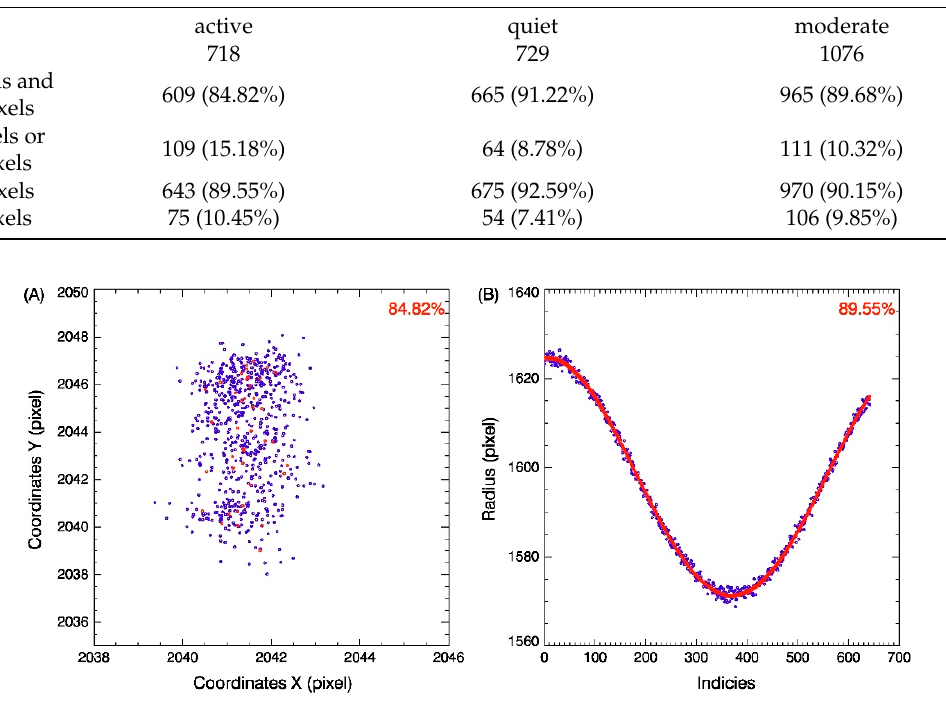
Figure 7. The image data was obtained in 2014, and the sun was more active. ( A ) is the comparison of the 609 samples of solar centers between our calculations (blue points) and the results of AIA (red points), and ( B ) is the comparison of the 643 samples of solar radii between our calculations (blue points) and the results of AIA (red points).